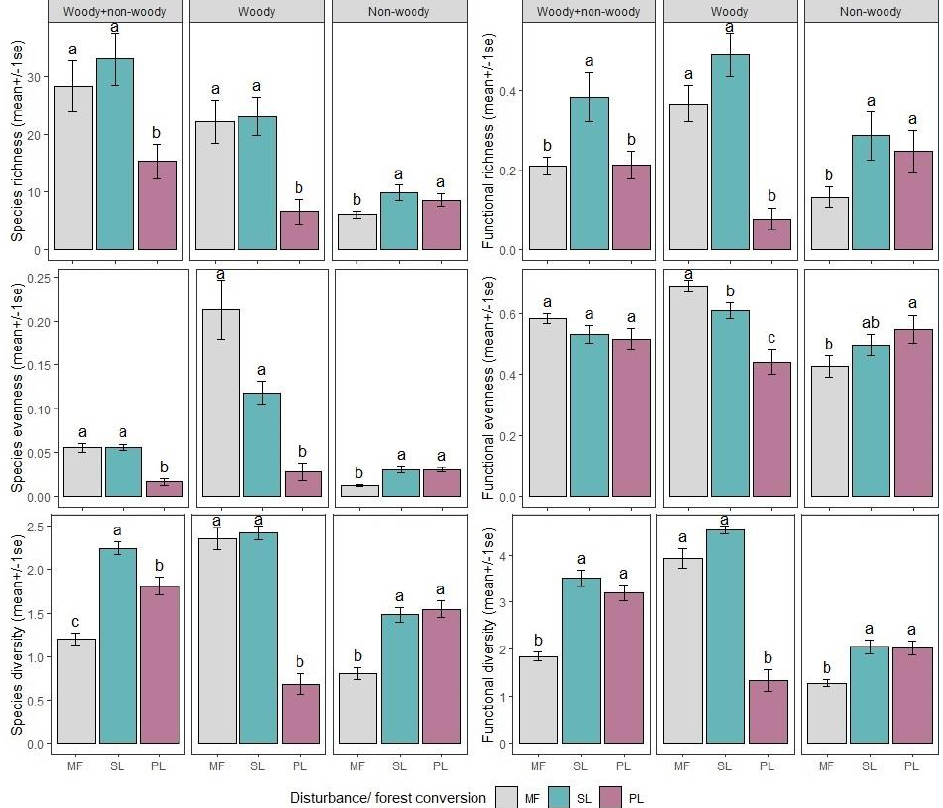
Figure 3. Variations in the mean values ( ± 1se) of different facets of species and functional diversity concerning habitat disturbance (MF = mature forests, SL = shrublands and PL = plantations) and vegetation layers. Bars marked with the same letters do not differ significantly at α = 0.05, as identified by Tukey’s post-hoc test.